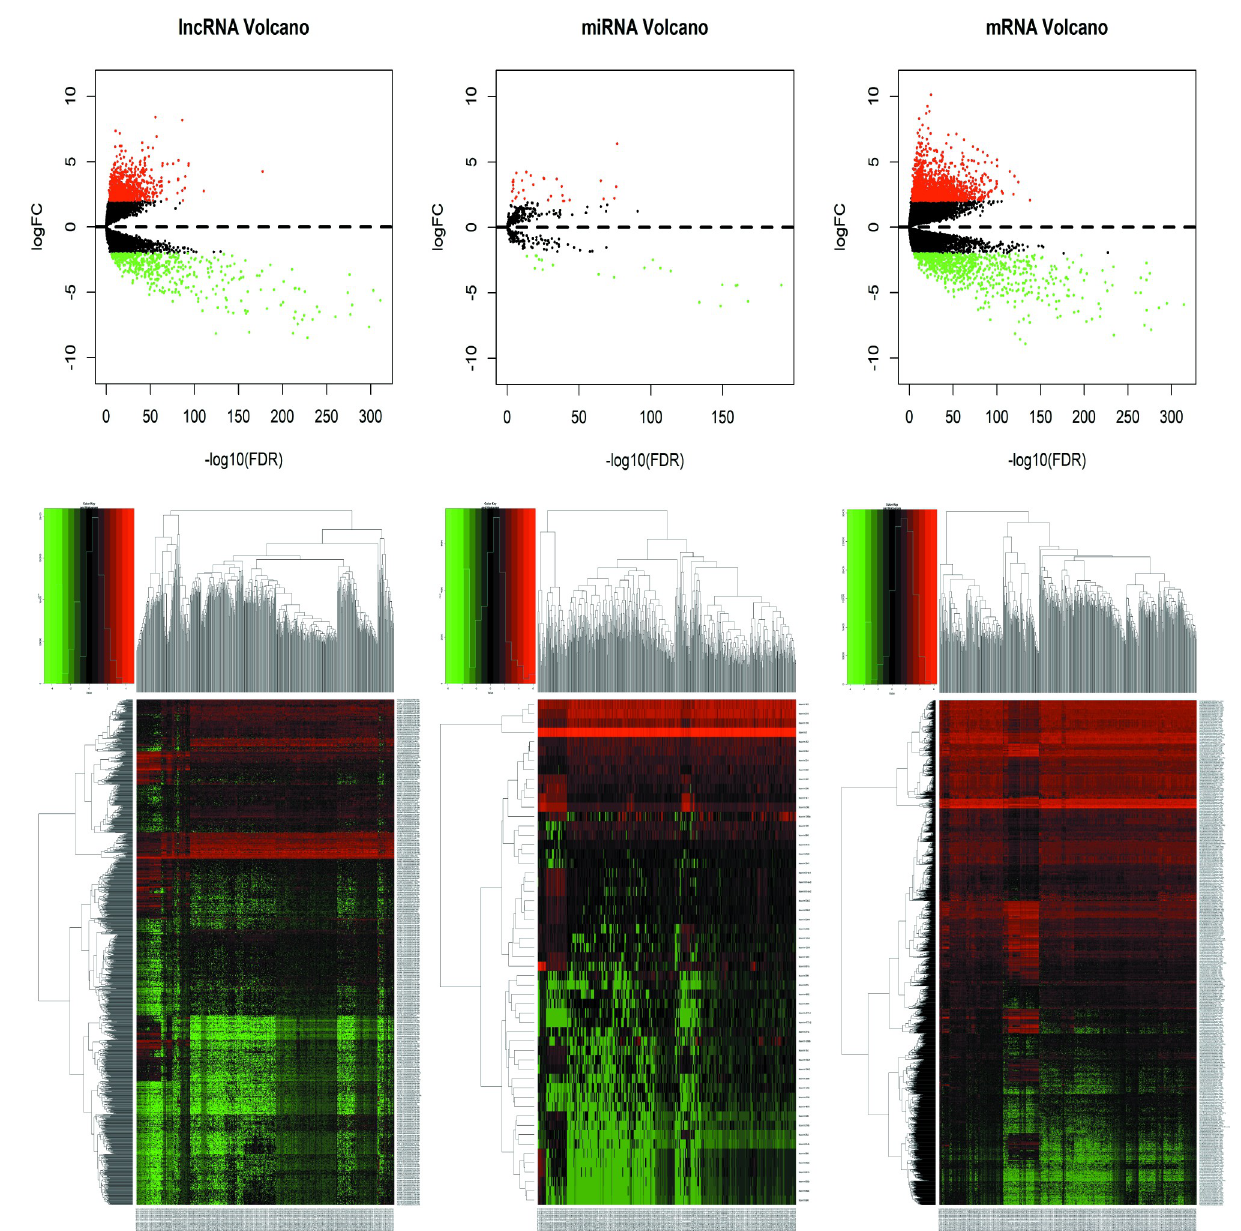
Fig 1. Volcano and heat maps of all differentially expressed RNA between KIRC and normal tissues. (a) Volcano map of DElncRNA in KIRC. (b) Volcano map of DEmiRNA in KIRC. (c) Volcano map of DEmRNA in KIRC. (d) Hierarchical clustering heat map of DElncRNA in KIRC. (e) Hierarchical clustering heat map of DEmiRNA in KIRC. (f) Hierarchical clustering heat map of DEmRNA in KIRC. FDR: False discovery rate.